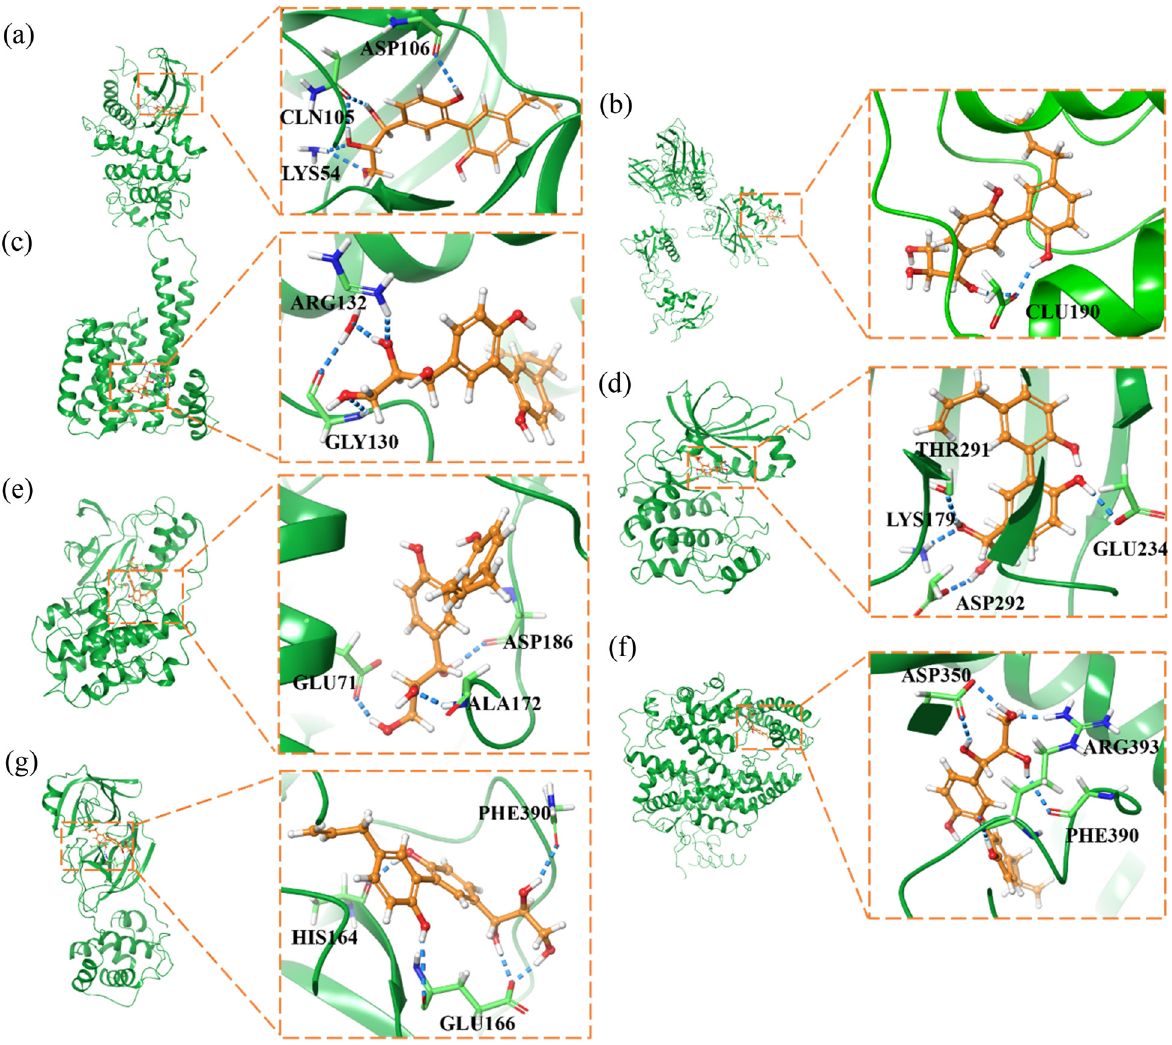
Figure 6: Binding mode of molecular docking, taking magnolignan B as an example. ( a ) MAPK1, ( b ) NFKB1, ( c ) RELA, ( d ) AKT1, ( e ) MAPK14, ( f ) ACE2, and ( g )